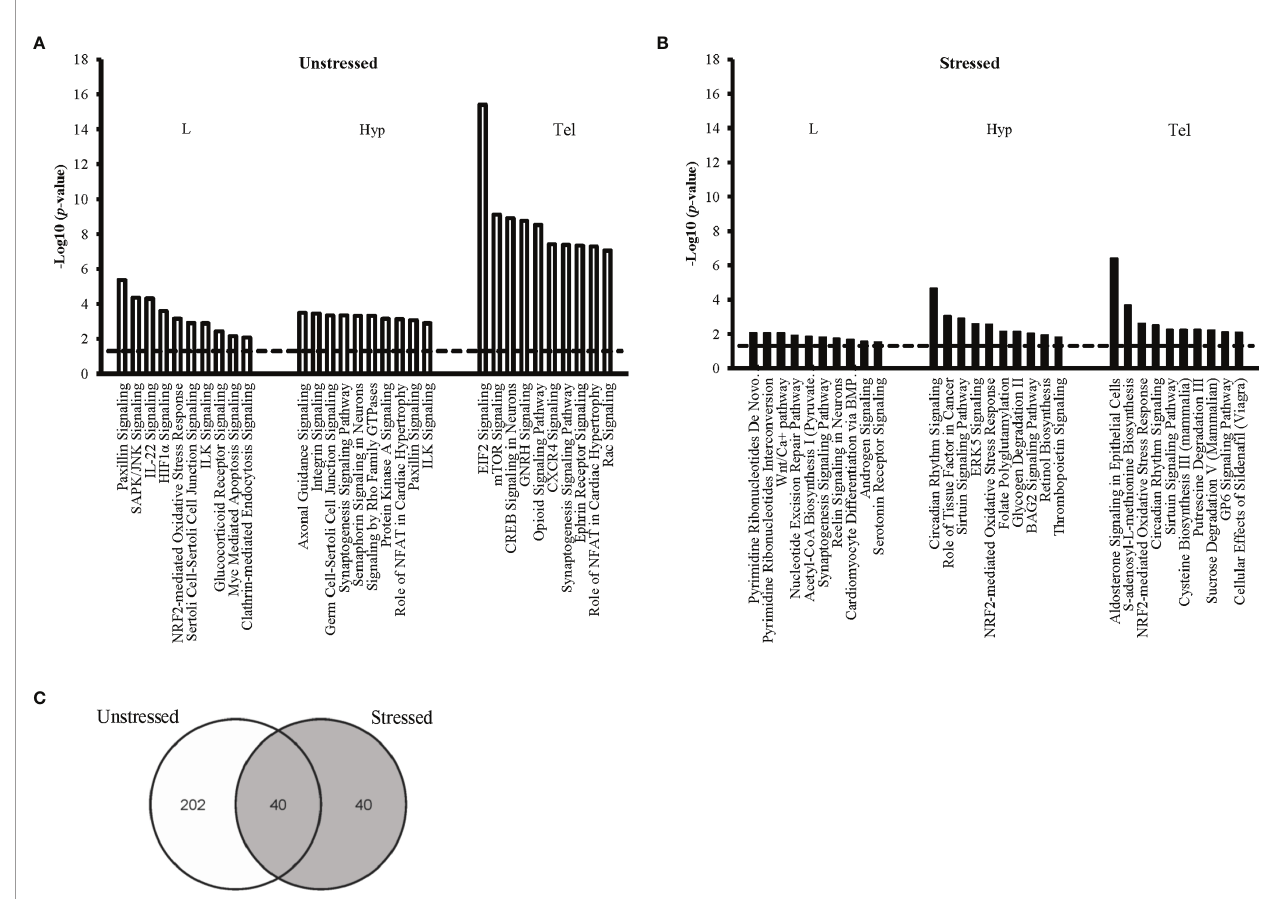
FIGURE 3 | Top ten affected canonical pathways following early-life exposure to fl uoxetine. The ten pathways with the highest level of signi fi cance (i.e. lowest p-value) for each target tissue are shown in larval heads (L), hypothalmus (Hyp), and telencephalon (Tel) in the unstressed (A) and the stressed (B) conditions. The y-axis presents the p-value associated with each pathway on a negative logarithmic scale (-log p-value). The horizontal dash line marks the negative logarithmic value related to the signi fi cance level p ≤ 0.05 [-log10( p )= 1.3]. Each bar shows a canonical pathway identi fi ed from the gene cluster enrichment function of IPA. The analysis was performed after converting the gene Ensembl ID of zebra fi sh ( Danio rerio ) to human ( Homo sapiens ) orthologues. Only genes with signi fi cant fold change (FC ≥ 1.2; FDR ≤ 0.05) were used for pathway enrichment analysis. (C) The Venn diagram shows the number of all signi fi cantly affected pathways in all tissue samples from both the unstressed and the stressed